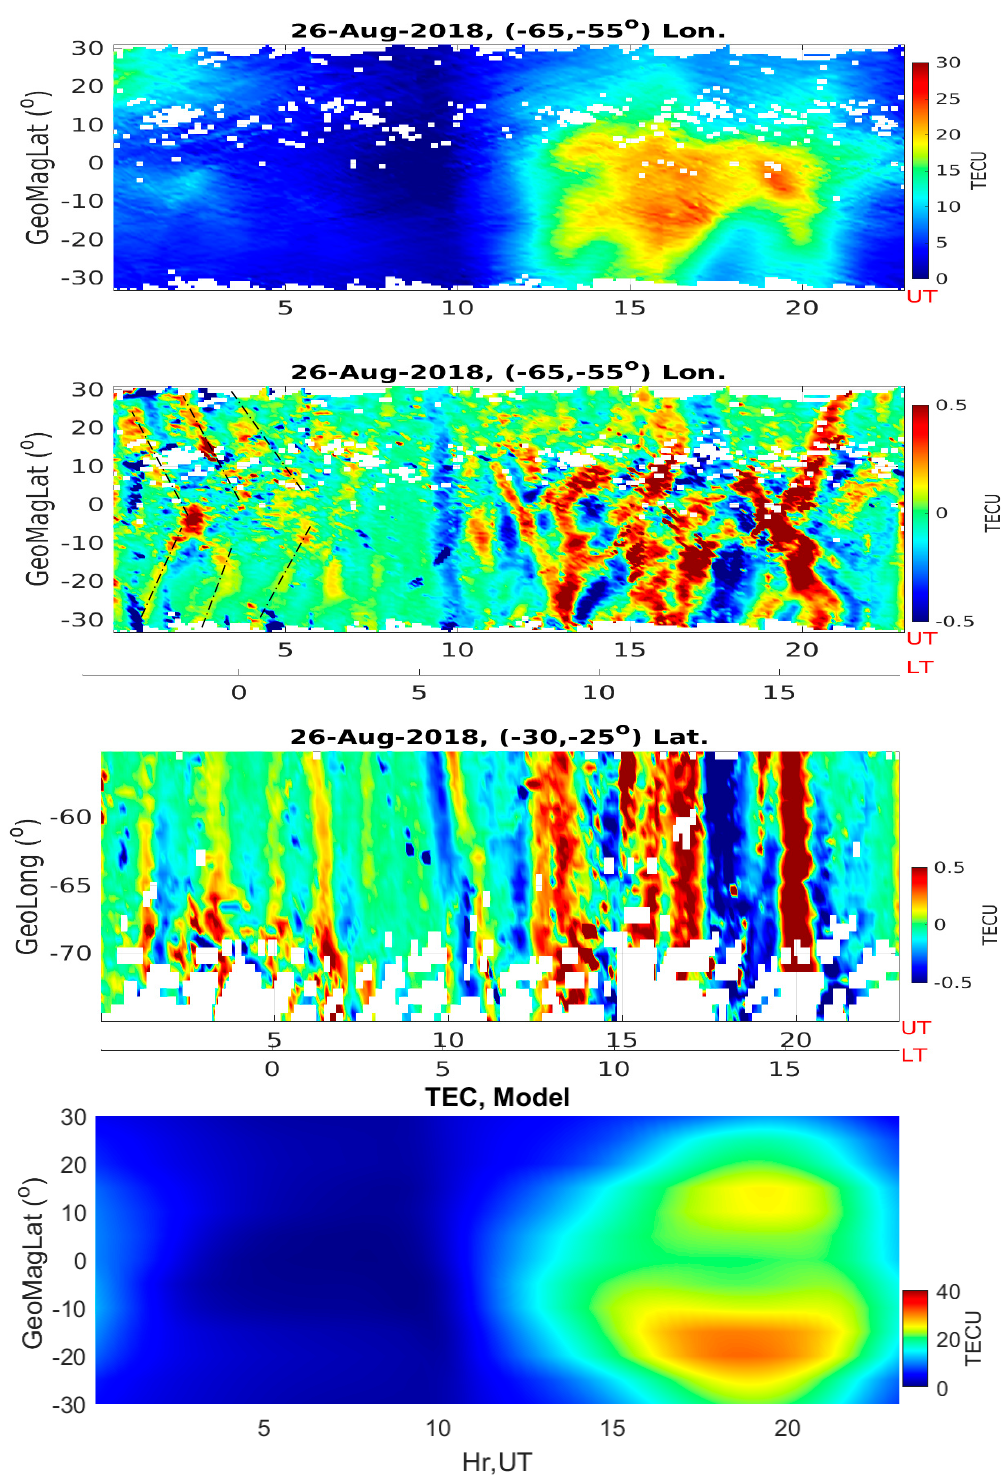
Figure 7. From top to bottom: keogram of background GNSS-TEC, keogram of TID obtained by removing the background TEC as a function of latitude and local and universal time, a keogram of TID as a function of longitude and local and universal time on 26 August 2018, and the simulation of TEC using the TIEGCM (at ±30° geomagnetic latitudes).